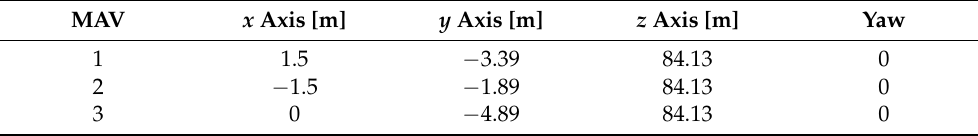
Table 2. Initial positions of UAVs.